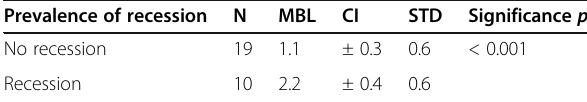
Table 1 MBL and prevalence of recession defects